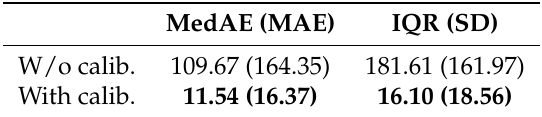
Table 1. Absolute errors in microseconds (µs) for calibrated and not calibrated gyroscopes for 1 kHz sample rate and 188 Hz cut-off